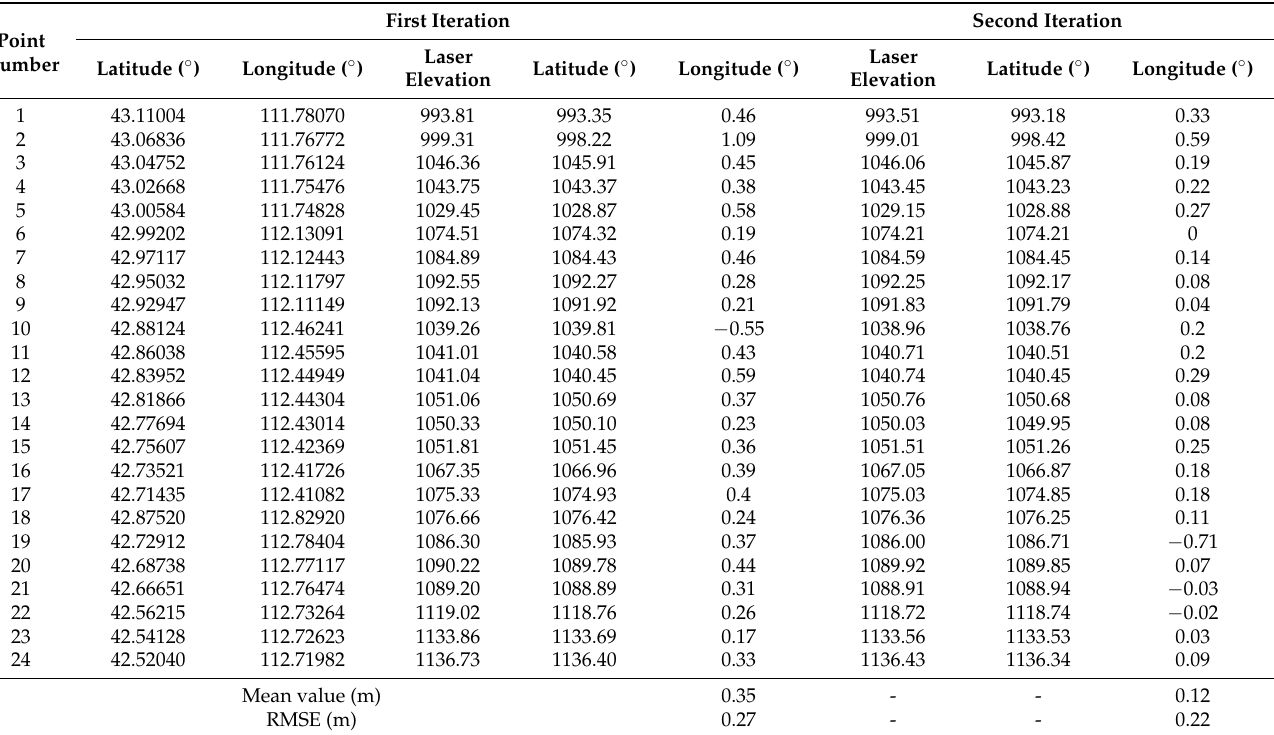
Table 4. The elevation accuracy of GF-7 laser beam 1 after iterative calibration based on AW3D30.